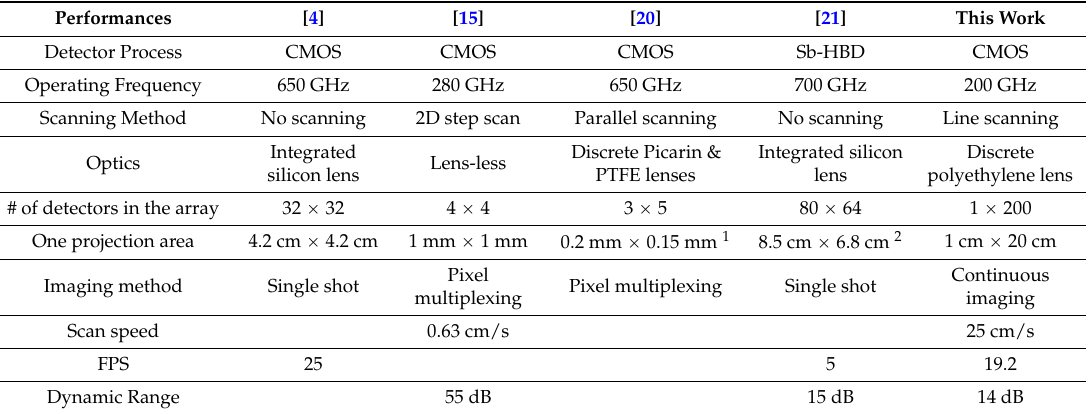
Table 2. The comparison of the THz imaging